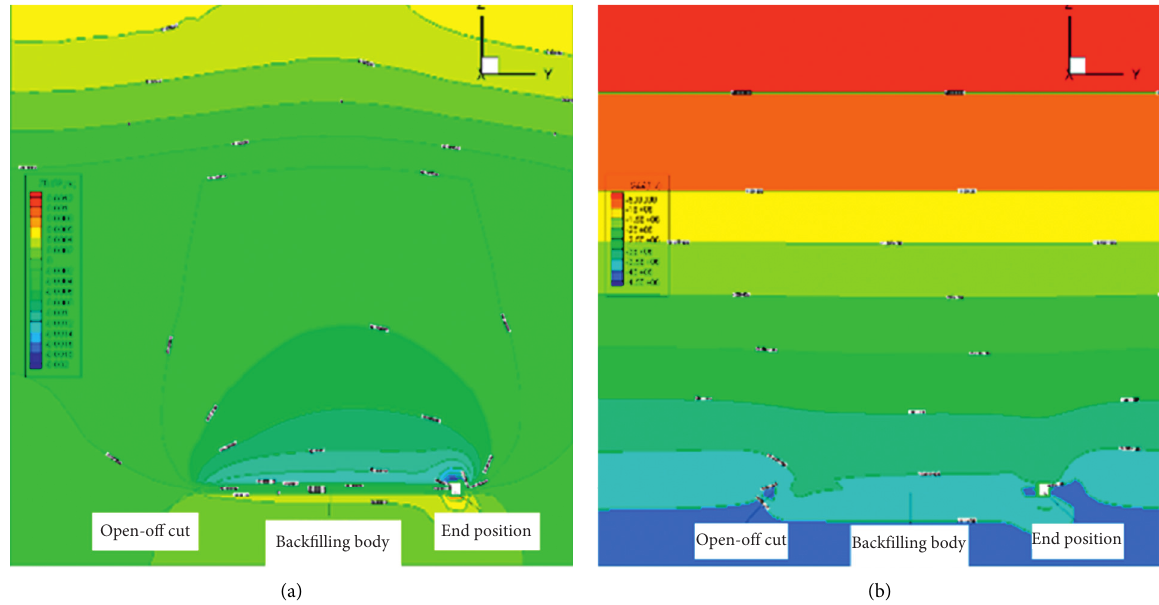
Figure 13: Movement of overlying strata when the working face advances for 100m under the elastic modulus of gangue of 15GPa. (a) Displacement vector of surrounding rock. (b) Distribution of vertical stress.